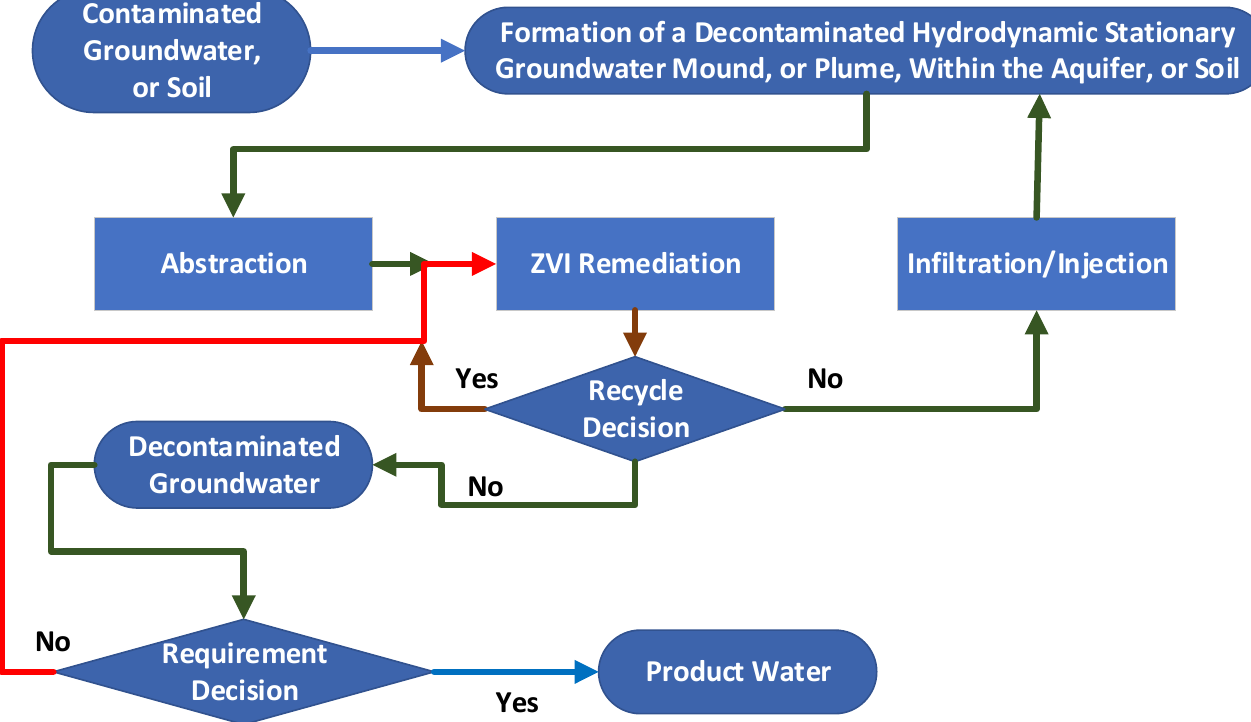
Figure 3. Process flow diagram showing the key elements associated with producing a decontami- nated hydrodynamic stationary plume within an aquifer, or a decontaminated hydrodynamic perched stationary groundwater mound in soil.